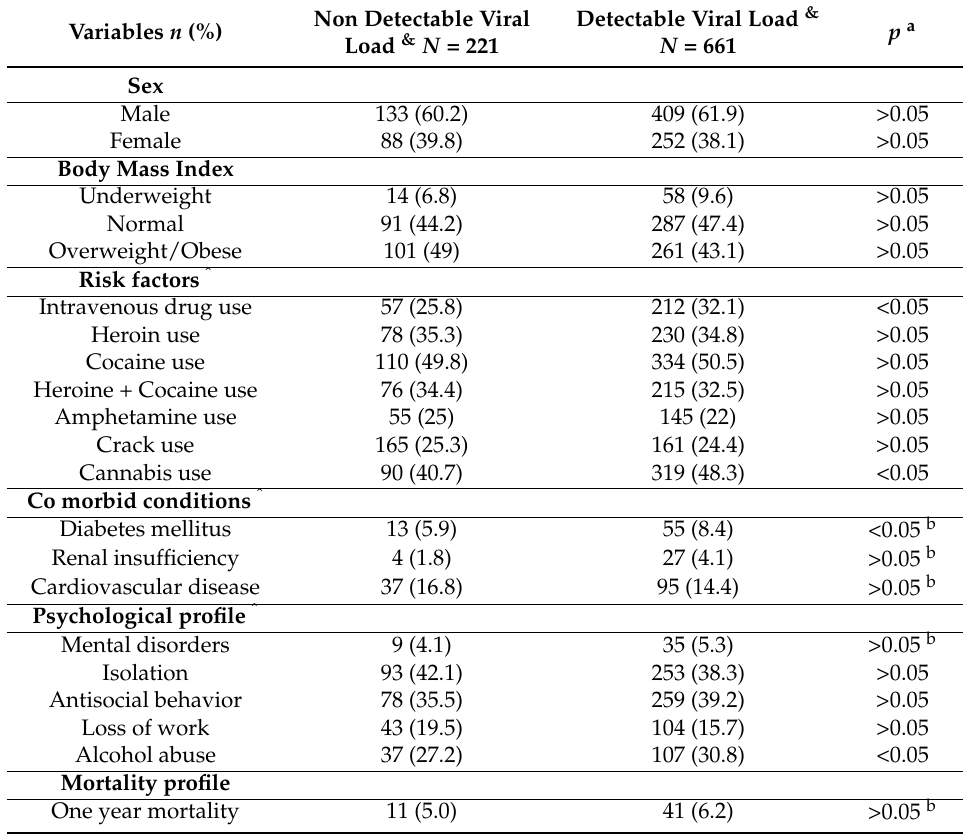
Table 1. Detectable and non-detectable viral load after steady ART use with sociodemographic, risk factors, co-morbid criteria, psychological profile and one year mortality. Puerto Rico, 2000–2011.